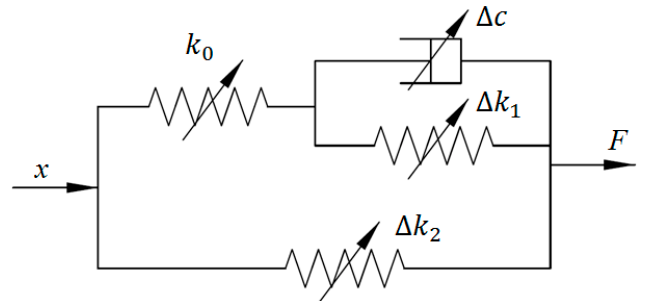
Figure 2. Four-parameter viscoelastic model.